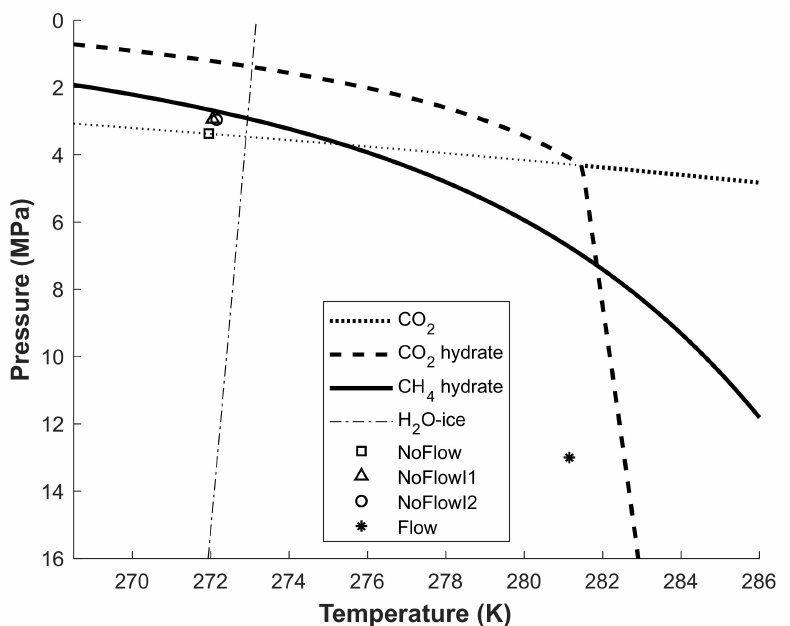
Figure 1. The CO 2 gas/liquid phase boundary, the water/ice Ih phase boundary [55], and phase boundaries for CH 4 hydrate and CO 2 hydrate in the pressure and temperature range relevant to the presented experiments. The liquid CO 2 phase and gas hydrates exist below the respective curves at higher pressures. Experimental conditions are marked with